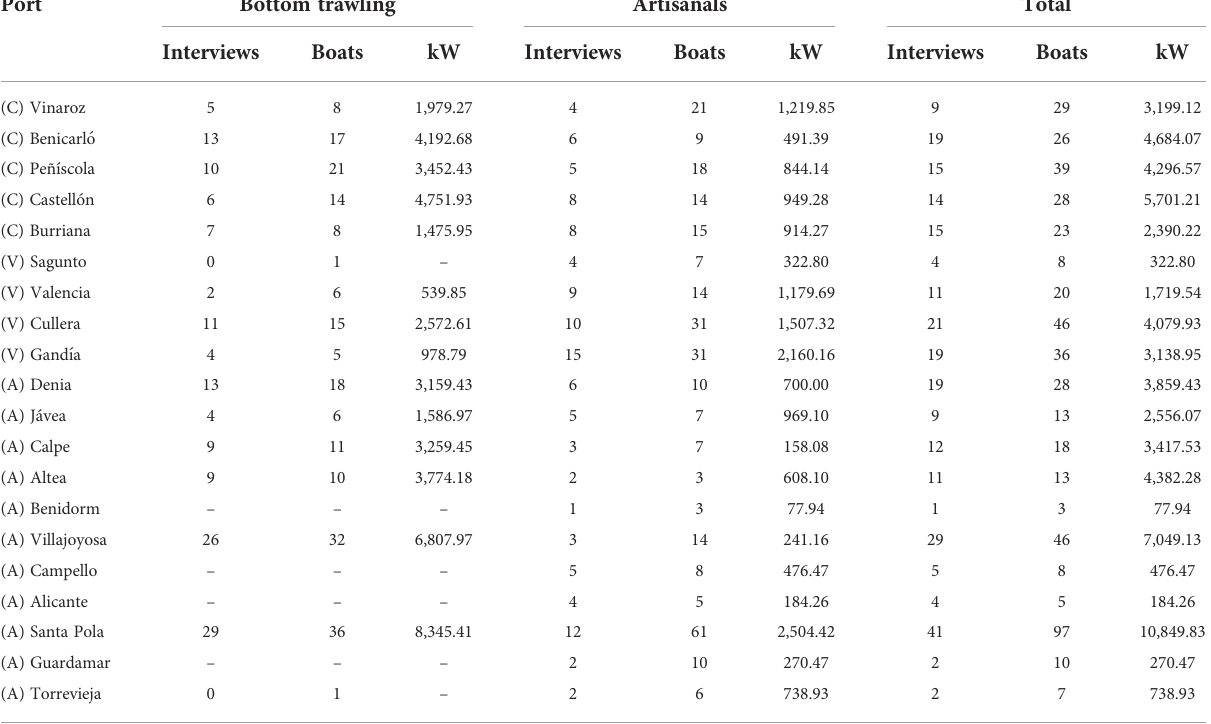
TABLE 1 Description of the fi shing fl eet in the Valencia region per port (north to south) at each province, Castellón (C), Valencia (V), and Alicante (A). We represent the number of censed vessels, the number of interviewed vessels and the total engine power (kW) for bottom trawling and artisanal vessels (Generalitat Valenciana, 2020; Ministry of Agriculture, Fisheries and Food, 2020). Port Bottom